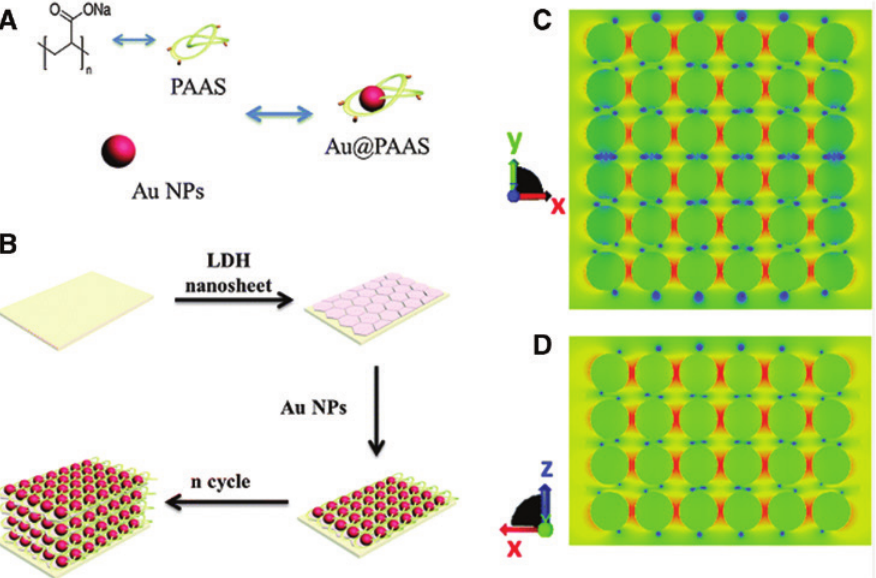
Figure 7: (A) Preparation of Au@PAAS precursor; (B) schematic representation of the assembly process; (C and D) finite-difference-time domain (FDTD) simulation in x - y and x - z planes. Reproduced from Tian et al. J. Mater. Chem. C , 2015 , 3 , 5167–5174, with permission from the Royal Society of